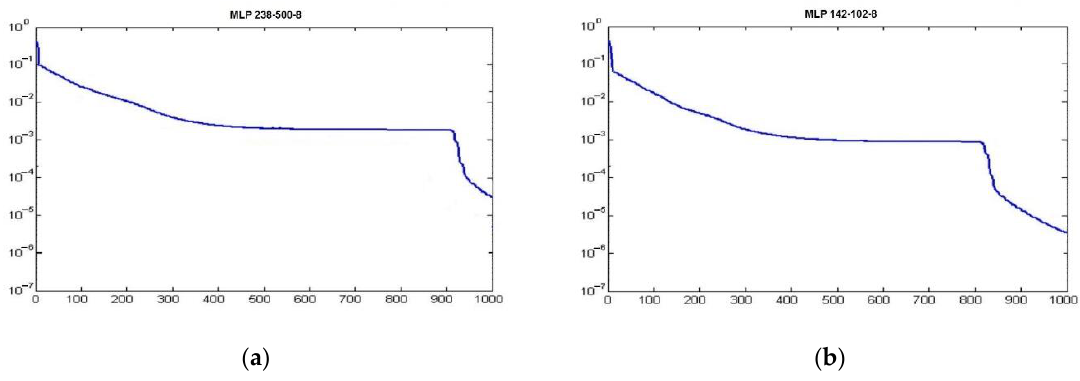
Figure 17. Values of mean square error (MSE) during learning: ( a ) MLP 238-500-8; ( b ) MLP 142-102-8).